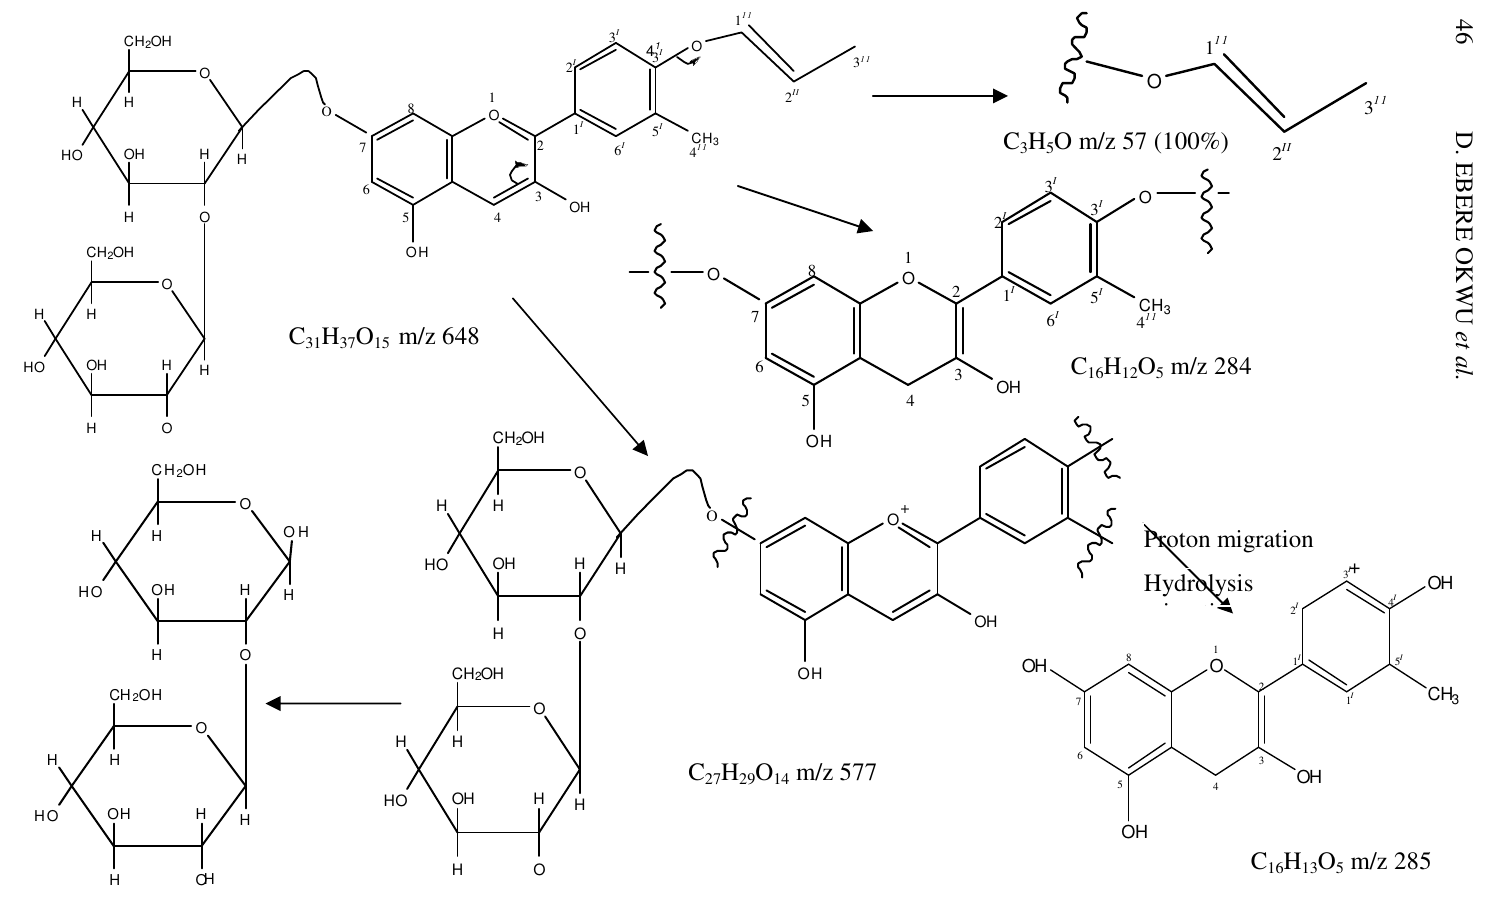
Figure 1. Fragmentation pattern of compound